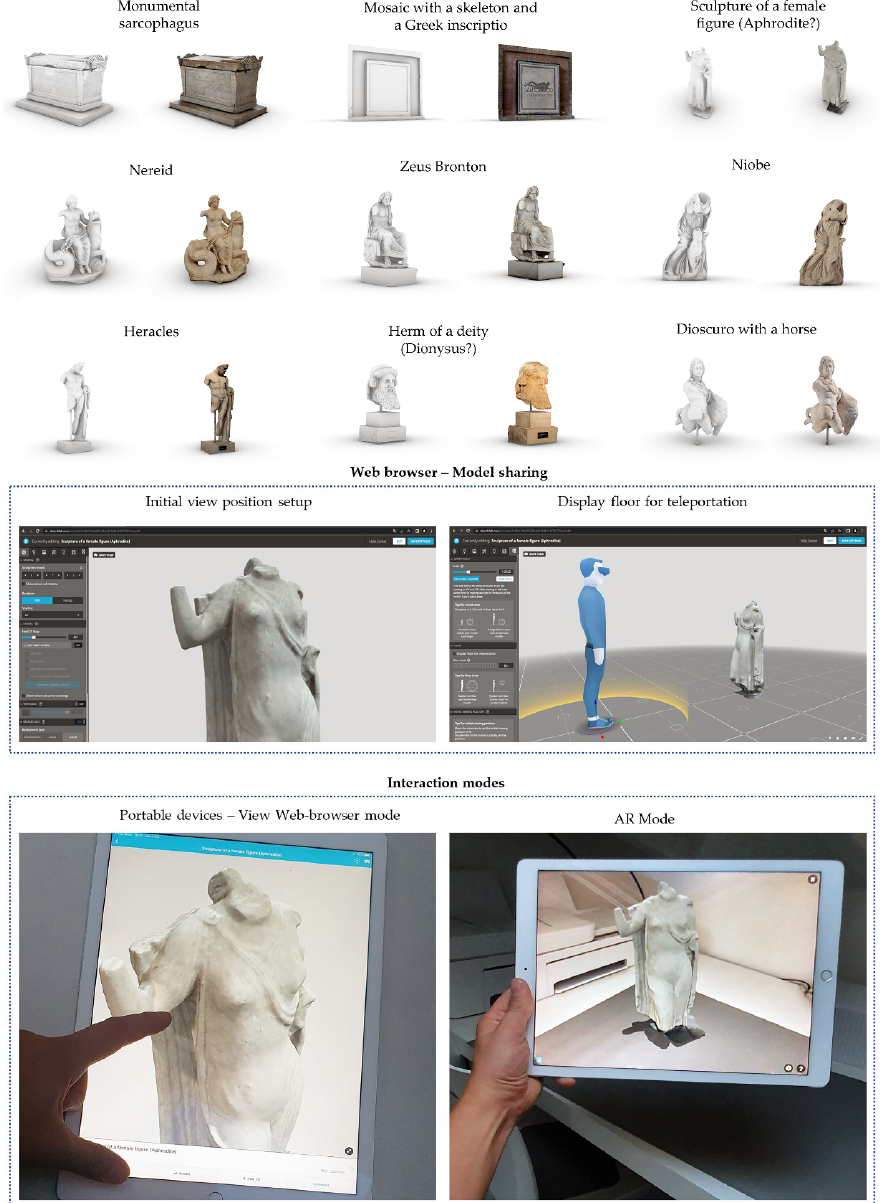
Figure 8. The models and 3D visualisation of Aphrodite’s sculpture: from the mesh model to the AR and 3D web viewer.